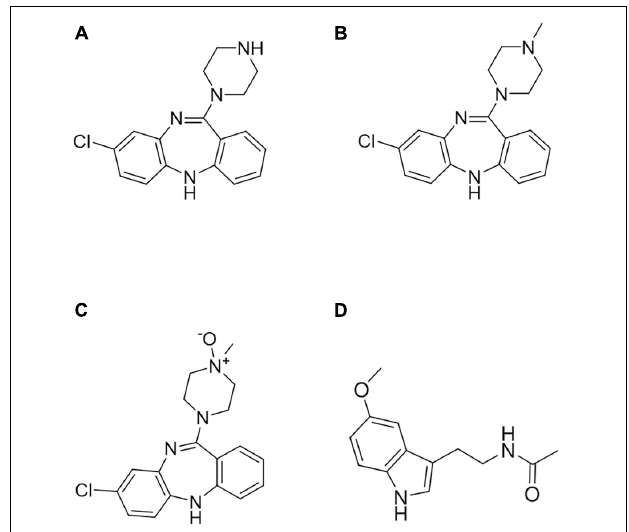
FIGURE 1 | Chemical structures of (A) clozapine (CLZ), (B) N -desmethylclozapine (DMC), (C) clozapine N -oxide (NOX), and (D) melatonin (internal standard,